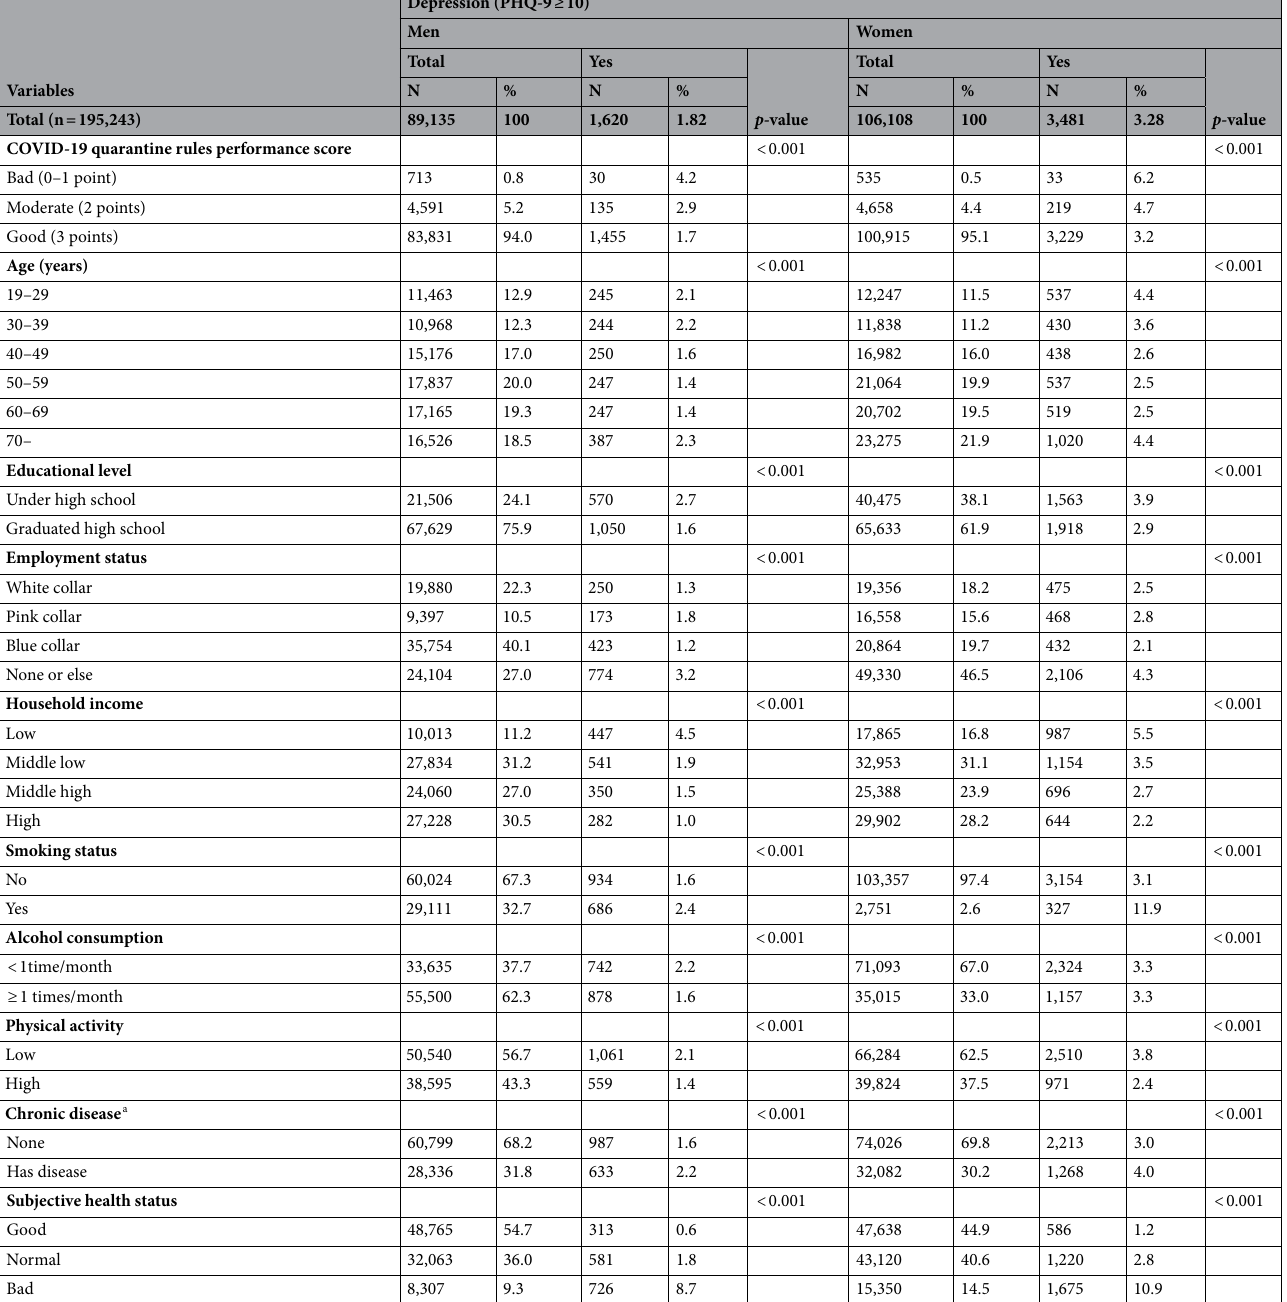
Table 1. General characteristics of study subjects. PHQ-9 Patient Health Questionnaire-9. a A chronic